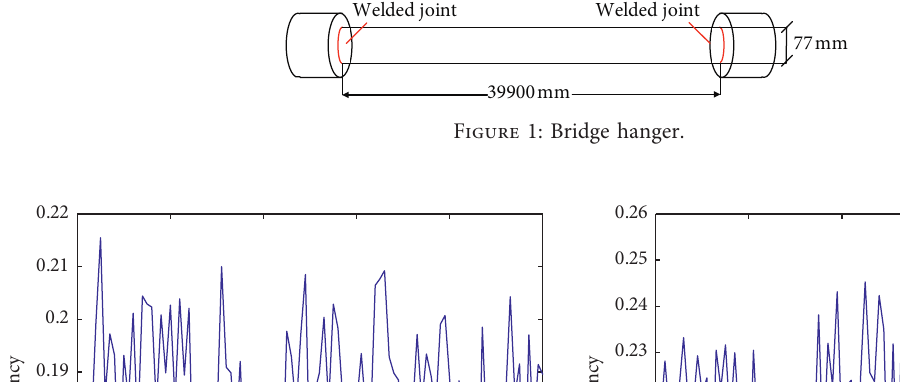
Figure 1: Bridge hanger.